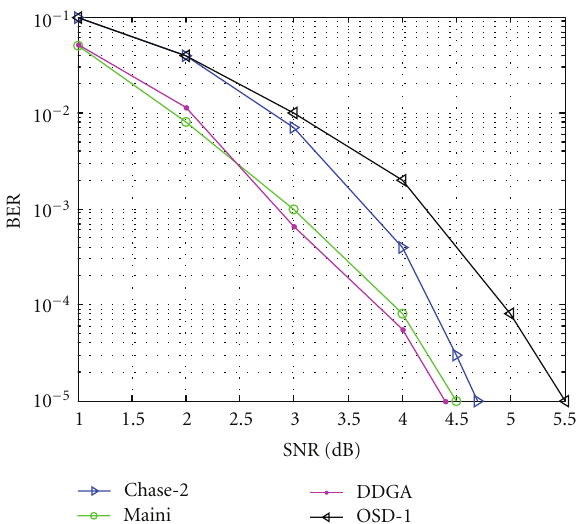
Figure 17: Performances of Chase-2, Maini, DDGA, and OSD-1 algorithms for BCH (127,64,21)